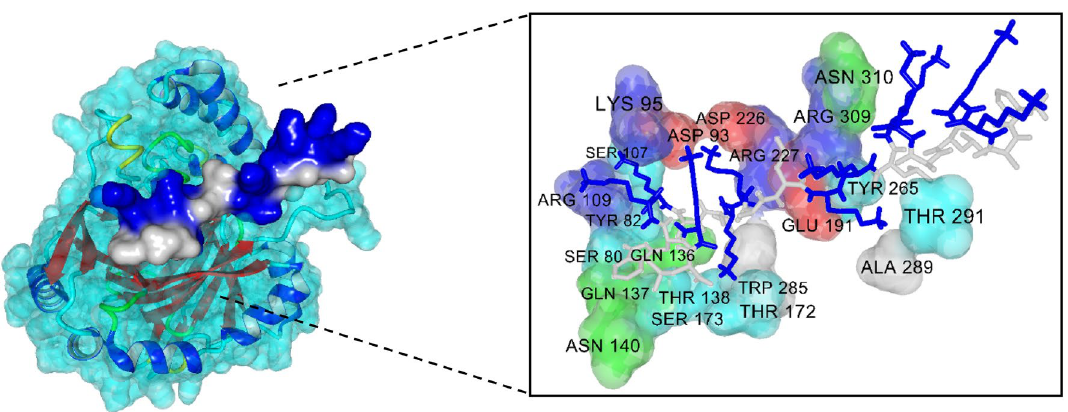
Figure 5. Molecular surface of docking complex between the HIF-1α receptor (left) and the peptide ID: 10 (right), in stick model, where amino acids in 3 Å binding, where Phe, Ala, Leu and Trp are non-polar residues (grey) and Lysis basic residue